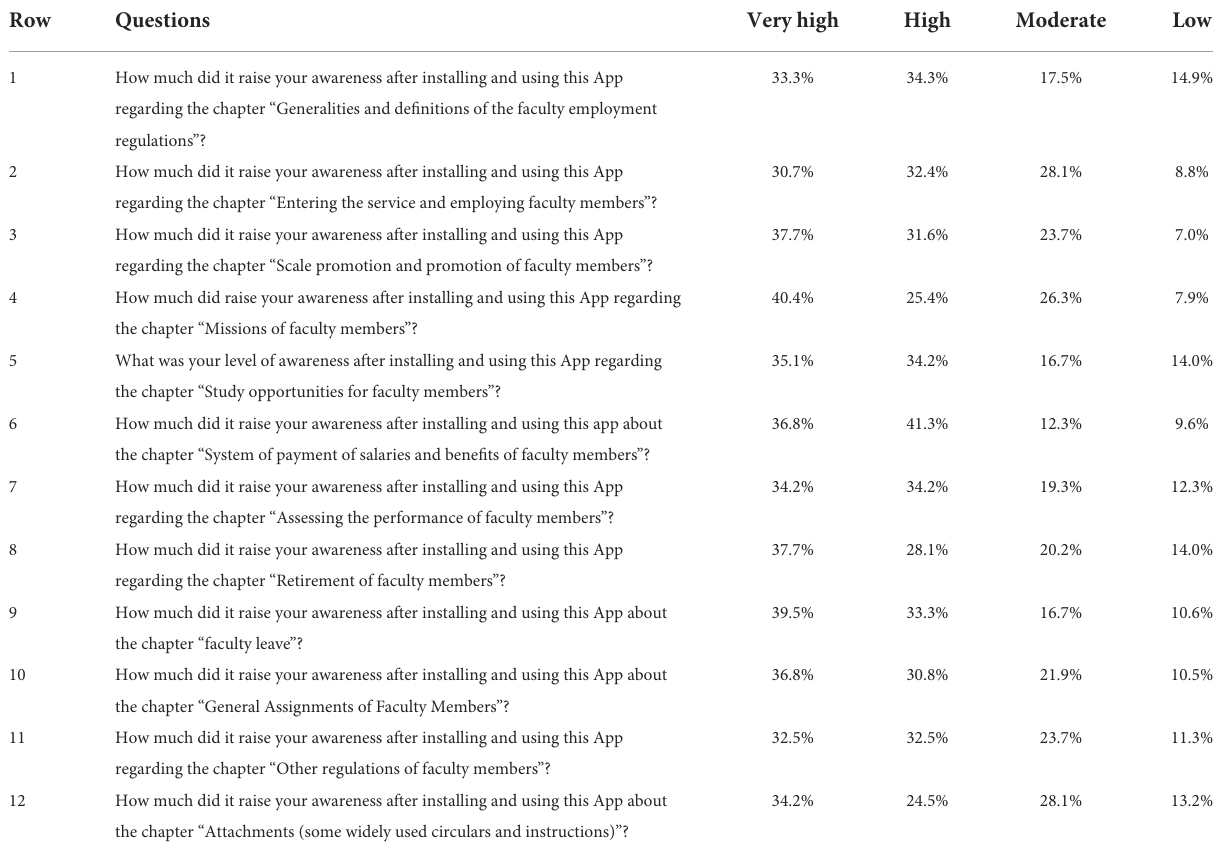
TABLE 2 Effect of M-Learning in promoting the awareness of faculty members according to the content of the App. Row